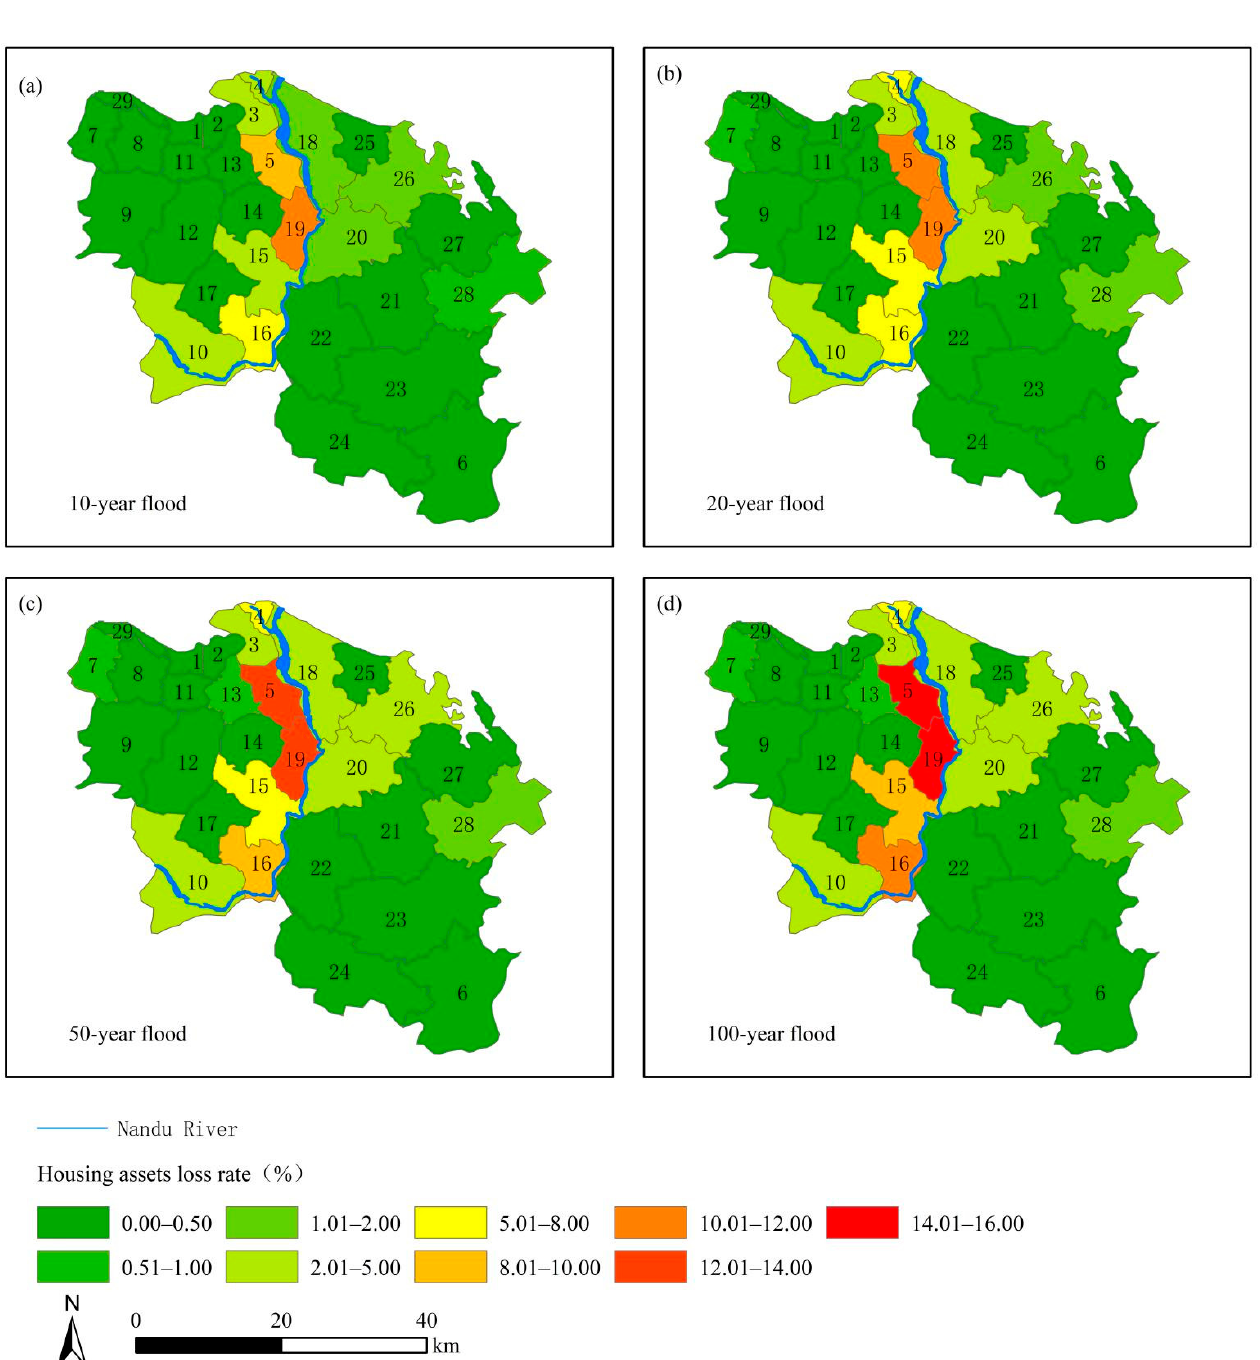
Figure 3. Housing asset loss rate in different flood return periods in Haikou City. ( a ) 10-year, ( b ) 20-year, ( c ) 50-year, ( d ) 100-year.